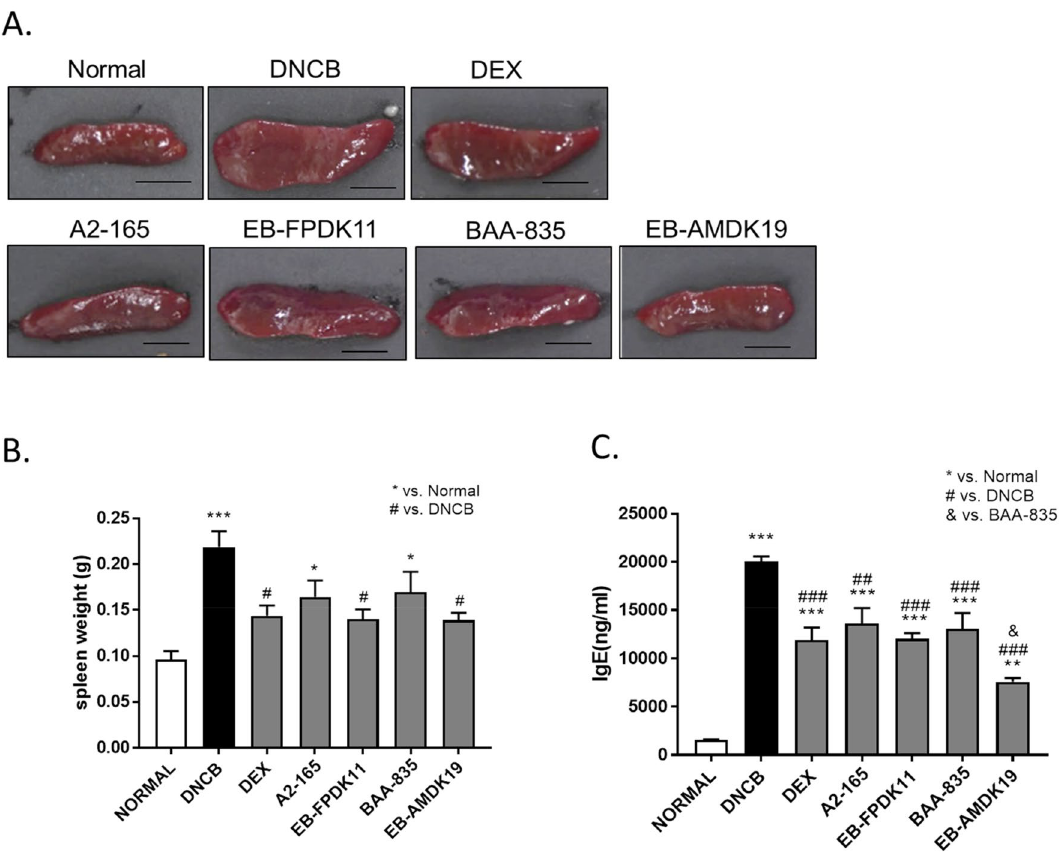
Figure 2. Effect of EB-FPDK11 and EB-AMDK19 on spleen and the total serum IgE levels in DNCB-induced AD-like mice. ( A ) Photograph of spleen from each group of mice to examine morphological alteration. Scale bar, 5 mm. ( B ) The spleen weight of 7 groups at 6 weeks after DNCB treatments. ( C ) Serum level of IgE was measured using ELISA. Data are presented as mean ± SEM of changes in values. * P < 0.05; ** P < 0.01; *** P < 0.001, *versus normal group; # versus DNCB group; $ versus DEX group; & versus BAA-835